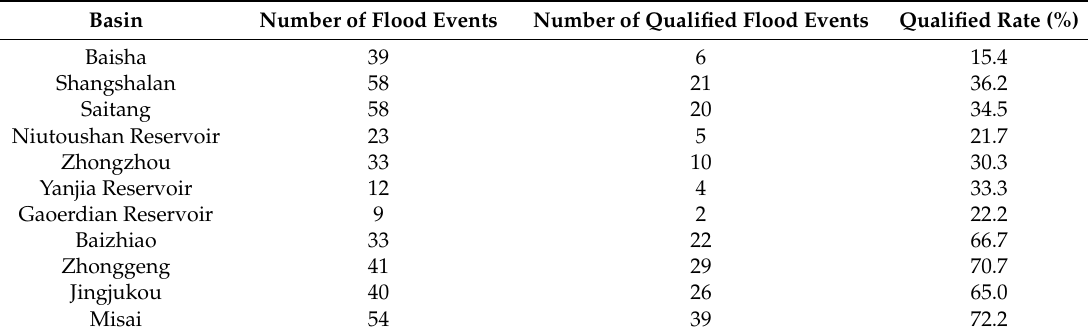
Table 9. Qualified rate of flood forecasting for the 11 studied